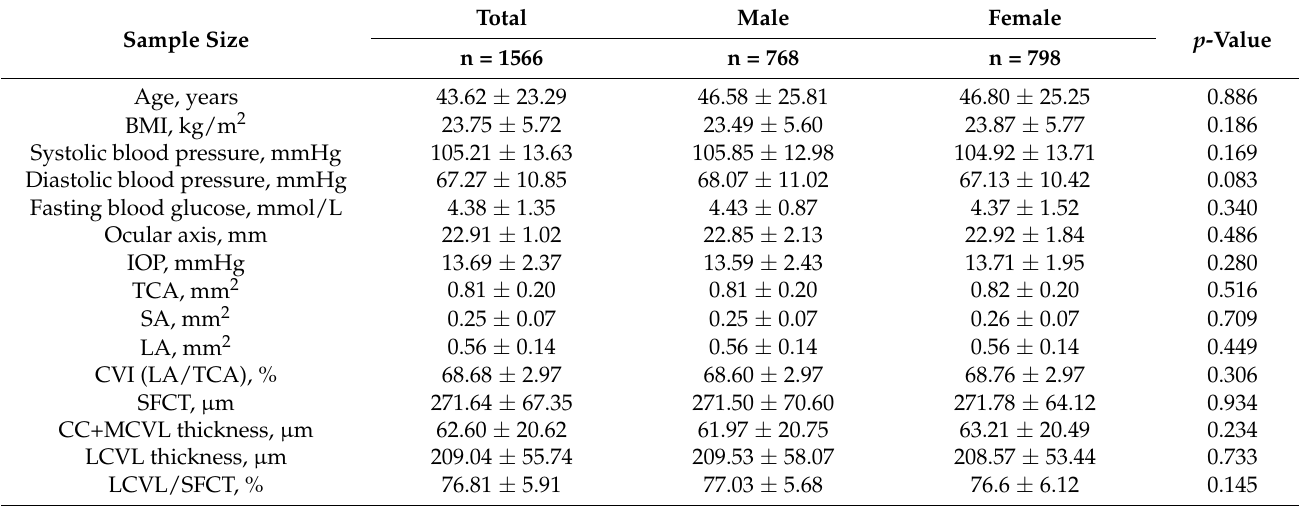
Table 1. Demographic profile and comparison of sex